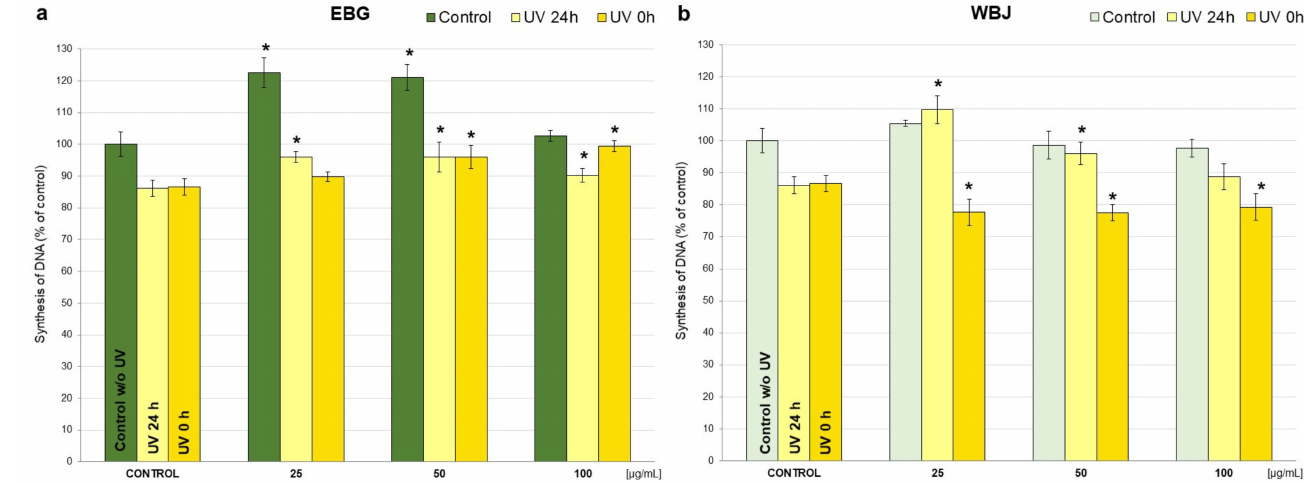
Figure 6. The effect of 70% ethanolic extract of young barley grass (EBG; ( a )) and water extract from young barley juice (WBJ; ( b )) at concentrations of 25, 50 and 100 µ g/mL on the incorporation of [3H]-thymidine into DNA of healthy and UV-treated NHSF cells after 48 h incubation with tested substances. The results are presented as a percentage of the control. * p < 0.05—statistically significant difference from corresponding control. Statistically significant difference between individual doses of tested extracts ( p < 0.05 EBG 25 vs. WBJ 25, EBG 50 vs. WBJ 50, EBG 25UV 24 h vs. WBJ 25UV 24 h, EBG 25UV 0 h vs. WBJ 25UV 0 h, EBG 50UV 0 h vs. WBJ 50UV 0 h, EBG 100UV 0 h vs. WBJ 100UV 0